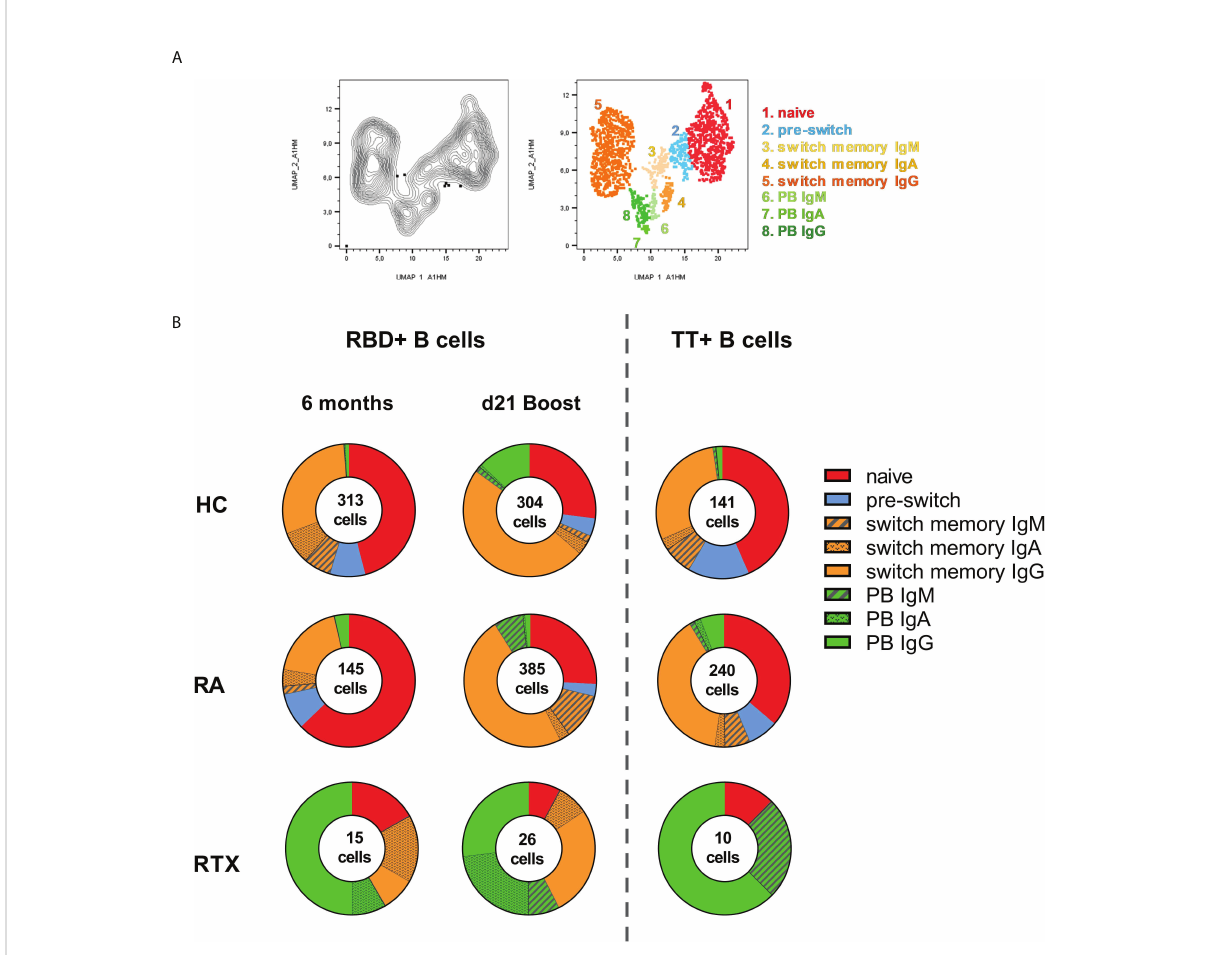
FIGURE 4 Distinct B cell subsets before and after 3 rd SARS-CoV-2 vaccination. UMAP (Uniform manifold approximation and projection for dimension reduction) clustering was performed on a concatenated fi le of pre-gated antigen speci fi c (RBD+ together with TT+) CD19+ B cells composed of total 1579 events. (A) Cluster overlay of B cells of all groups for subset identi fi cation. (B) Distribution of clusters before and after 3 rd vaccination, as well as for TT+ B cells in HD, RA and